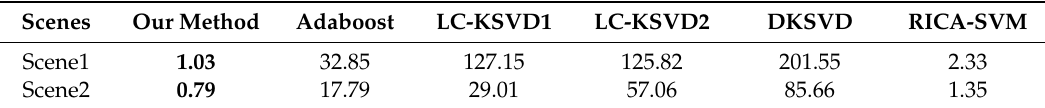
Table 4. Running time of point cloud classification on Scene1 and Scene2 (Unit: second). Note that the best results are highlighted in